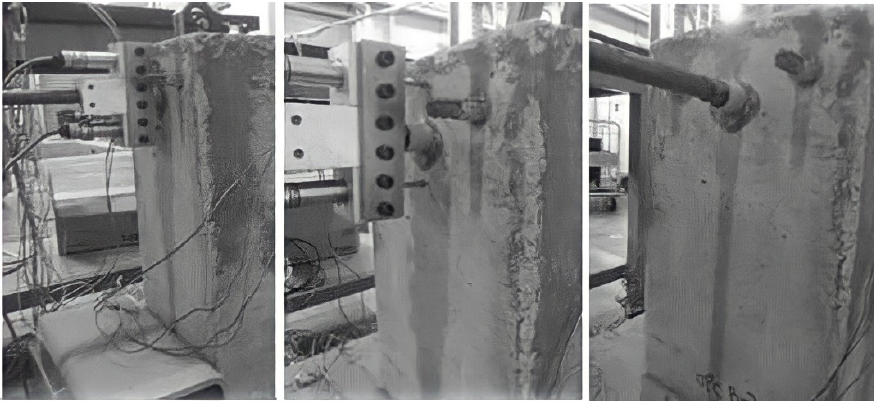
Figure 4. Front face images of the beam end test of plain bar reinforced OPC specimens: photos that were taken before (left), during (middle) and after (right) the beam end test.